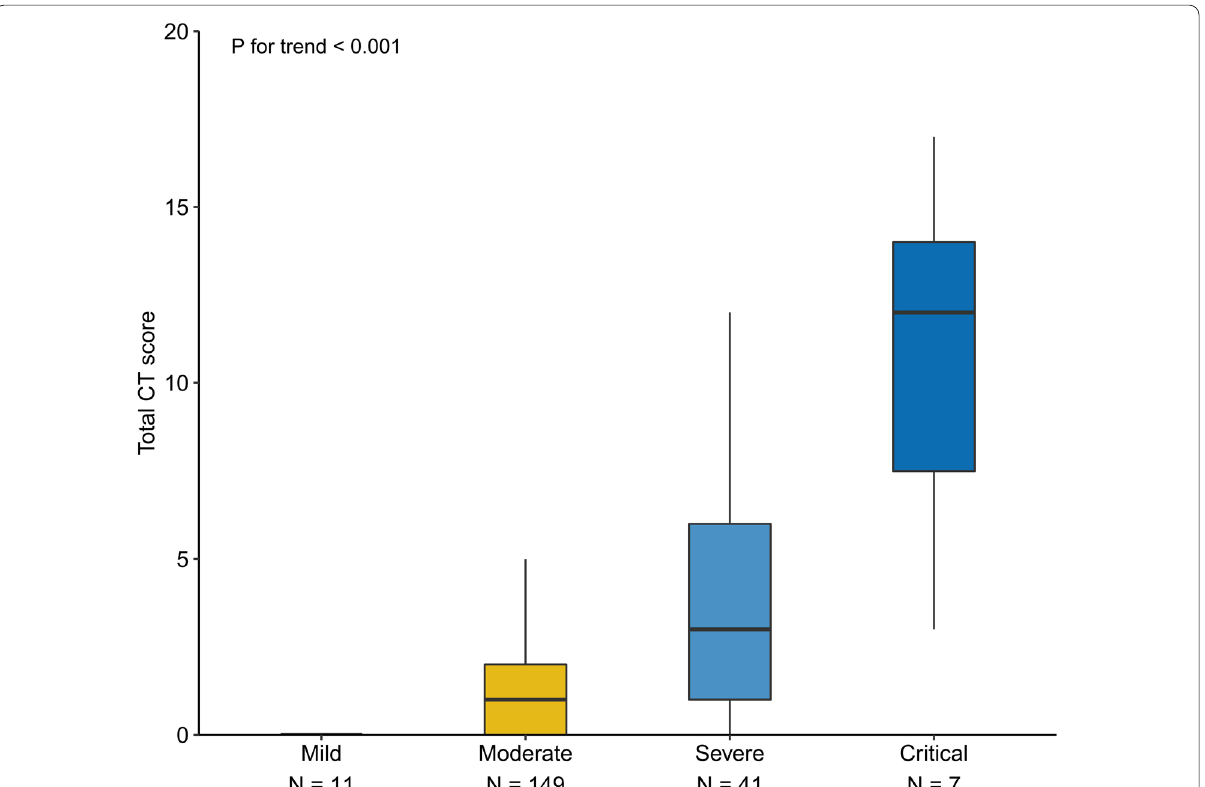
Fig. 3 Total CT scores in recovery patients with different disease severity at 1-year follow-up. The trend was determined by linear regression